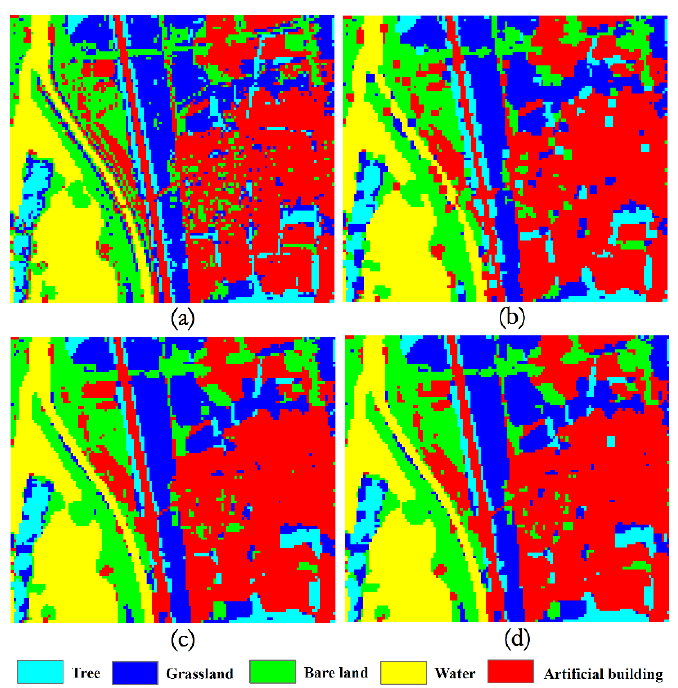
Figure 9. Classification maps of Vaihingen image: ( a ) OCM, ( b ) RCM_SU, ( c ) RCM_SDU, and ( d ) RCM_CU.